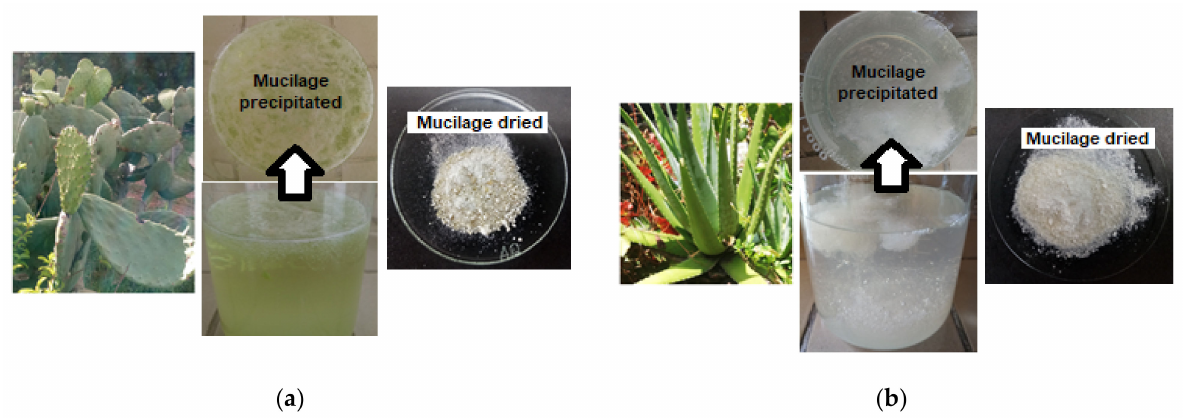
Figure 1. Appearance of the purified mucilage: ( a ) mucilage extracted from OFI cladodes; ( b ) mucilage extracted from Aloe Vera